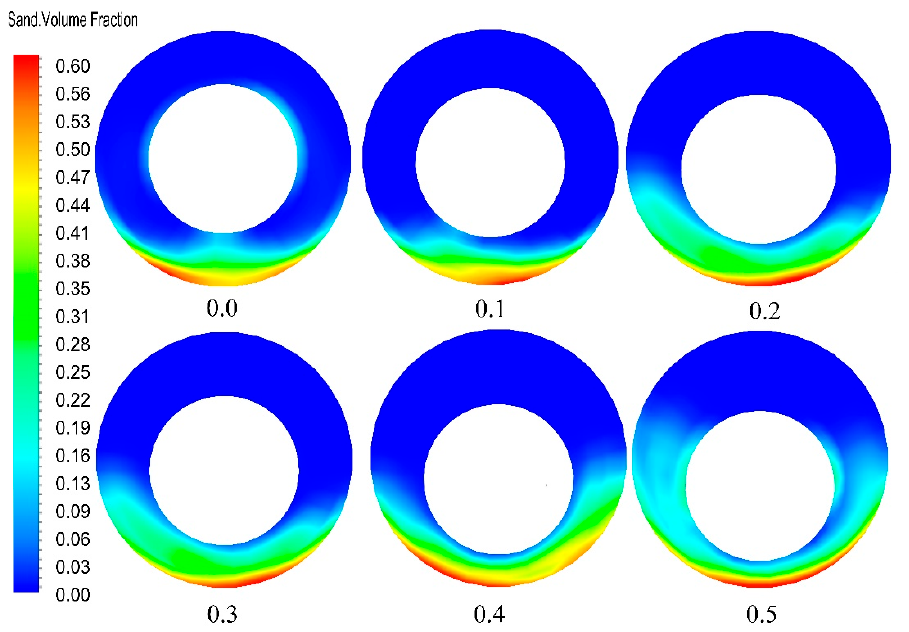
Figure 19. The contour of the effect of string eccentricity on the volume